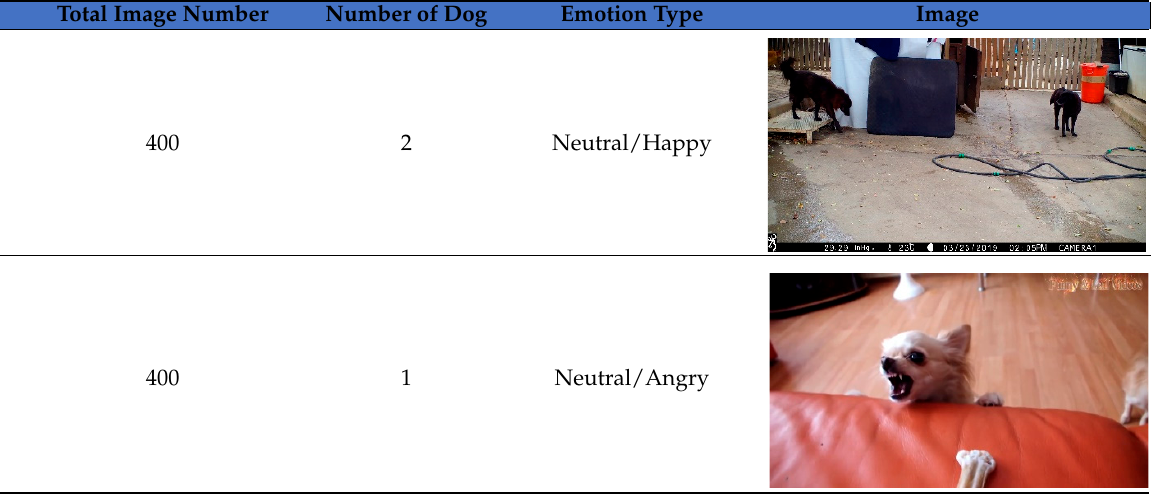
Table 9. Test data-set of integrated system.